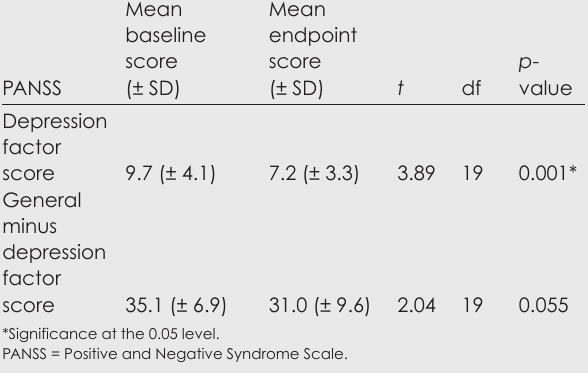
Table II. Change in PANSS depression factor score and general psychopathology score with depression factor items